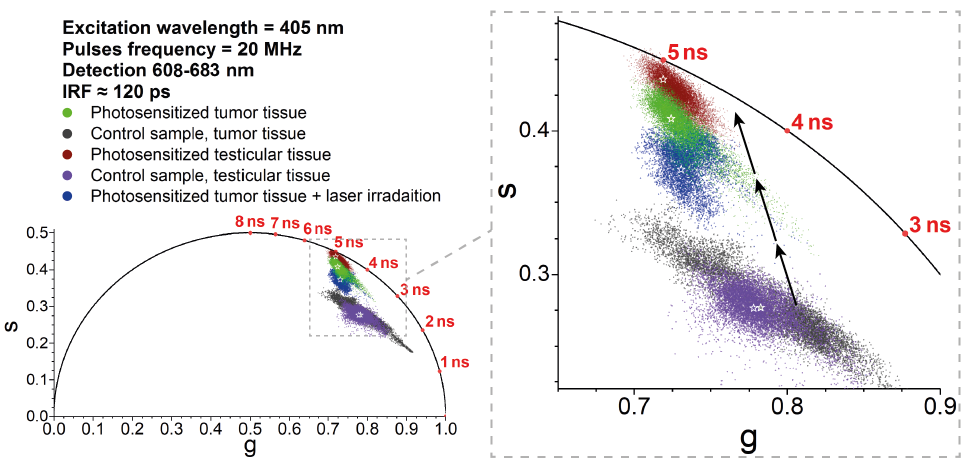
Figure 3. Phasor plot of the data from five analyzed samples on the time-resolved fluorescence signals within the spectral range of 608–683 nm. Note that to obtain reliable results, the phasor plot’s points were collected from several fields of view in each sample. The stars indicate the positions of the central mass coordinate for each sample. The black arrows indicate shifts of the phasor plot’s position with increasing Radachlorin concentration. The fluorescence signals from the control samples were due to the autofluorescence of the